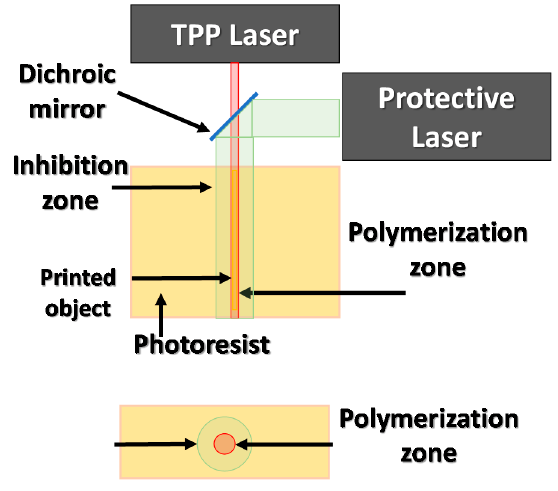
Figure 17. Stimulated emission induced depletion method scheme.